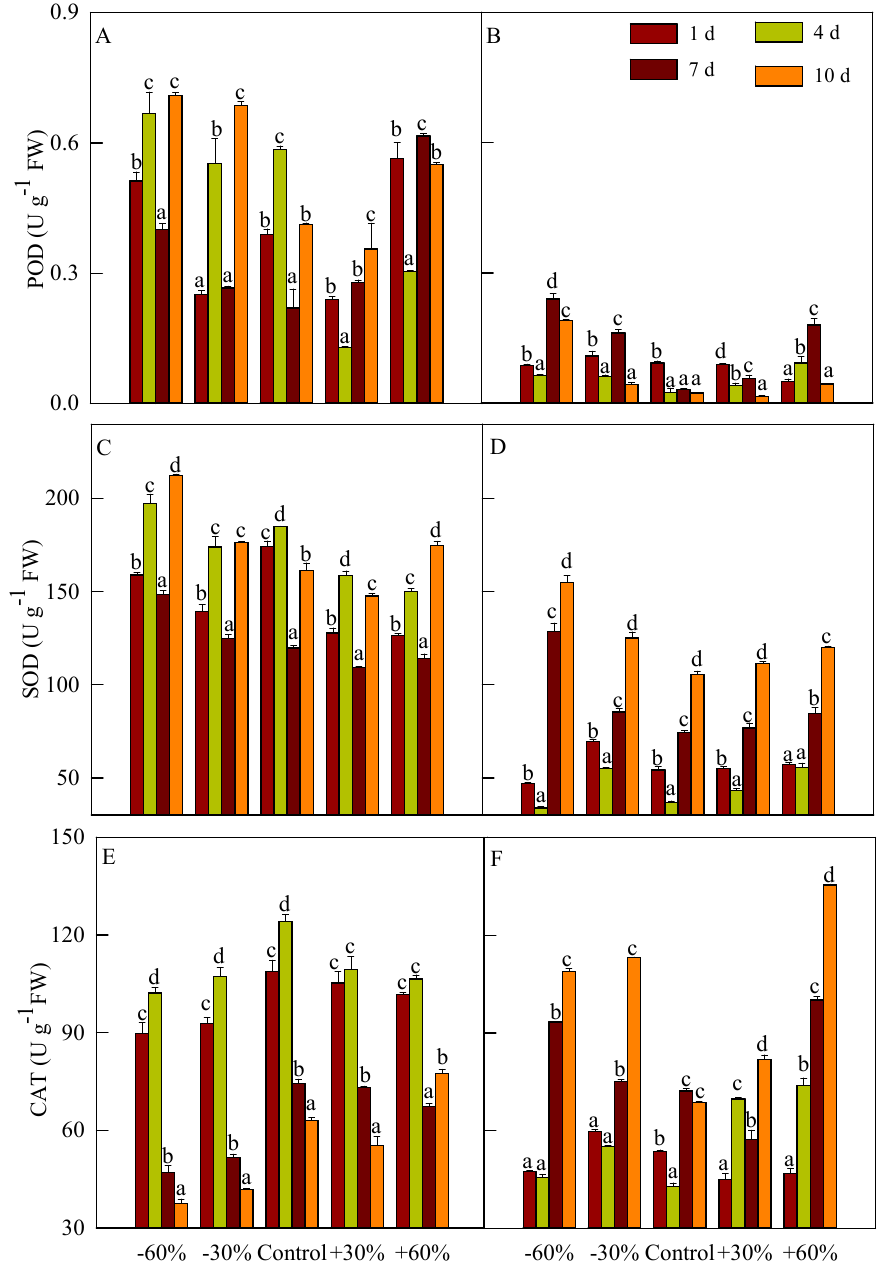
Figure 4. Influence of di ff erent precipitation treatments on antioxidant enzymes. ( A ): Peroxidase (POD) of T. terrestris ; ( B ): POD of B. dasyphylla ; ( C ): Superoxide dismutase (SOD) of T. terrestris ; ( D ): SOD of B. dasyphylla ; ( E ): Catalase (CAT) of T. terrestris ; ( F ): CAT of B. dasyphylla . Values are assigned as the mean ± SD.